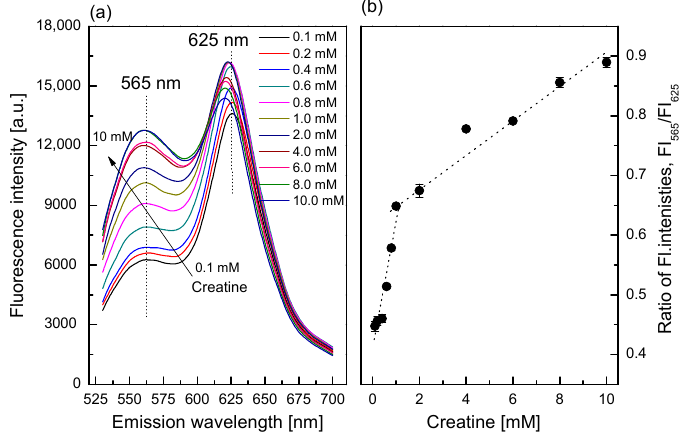
Figure 2. ( a ) Fluorescence emission spectra of the creatine-sensing membrane in the presence of creatine at 0.1 to 10 mM concentration monitored at an excitation wavelength of 460 nm. ( b ) Calibration curve for creatine calculated by the ratio of two fluorescence intensities measured at emission wavelengths of 565 and 625 nm.